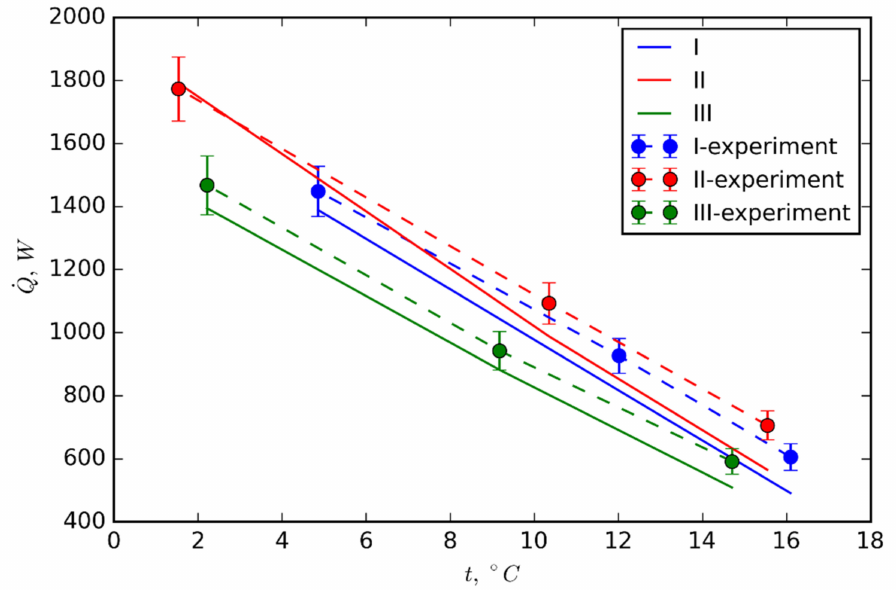
. Q from model and experimental for varying volumetric